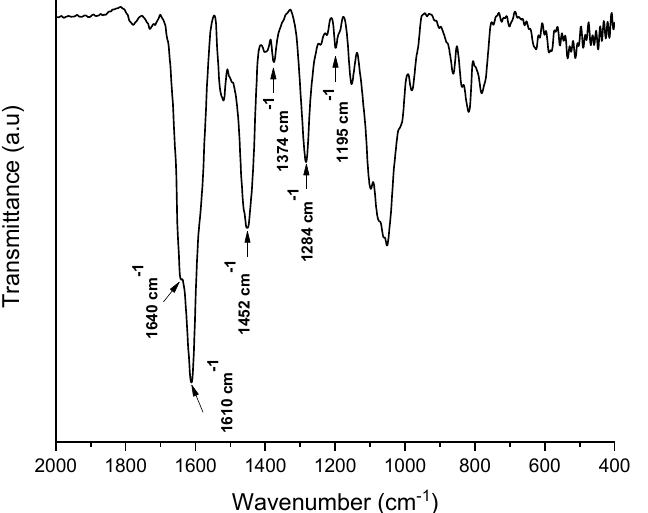
Figure 4. FTIR spectrum of the extract obtained from the mangosteen peel.